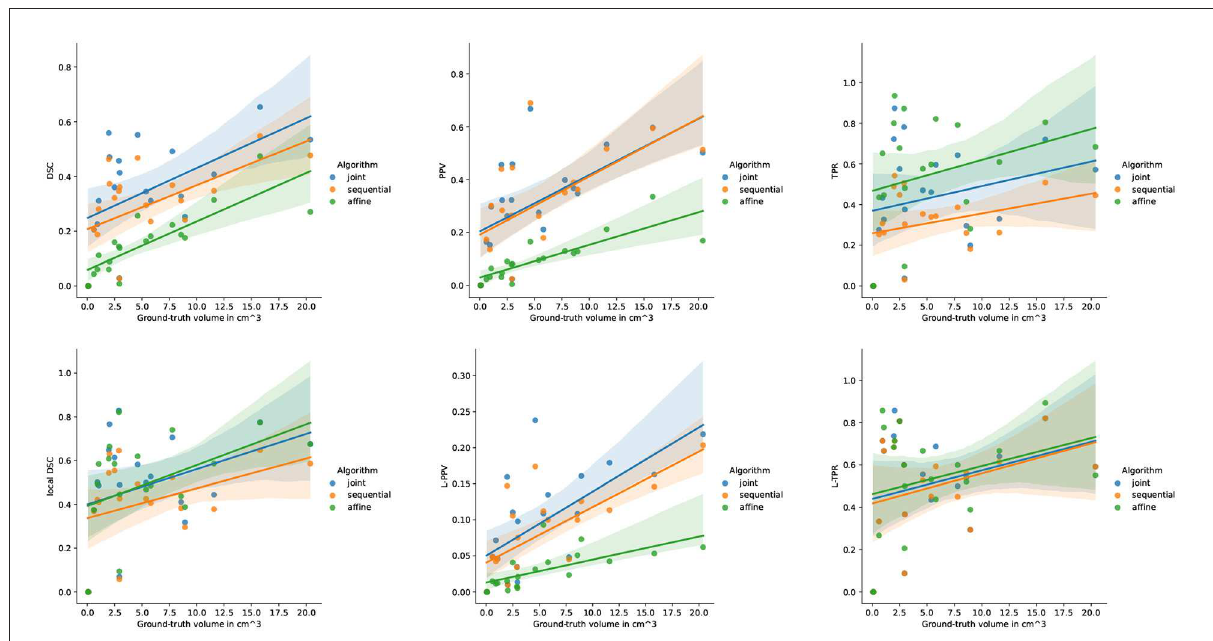
FIGURE7 Correlation between the performance of the three methods and the ground-truth evolving lesion load (cm 3 ) of the subjects of LesjakDB.